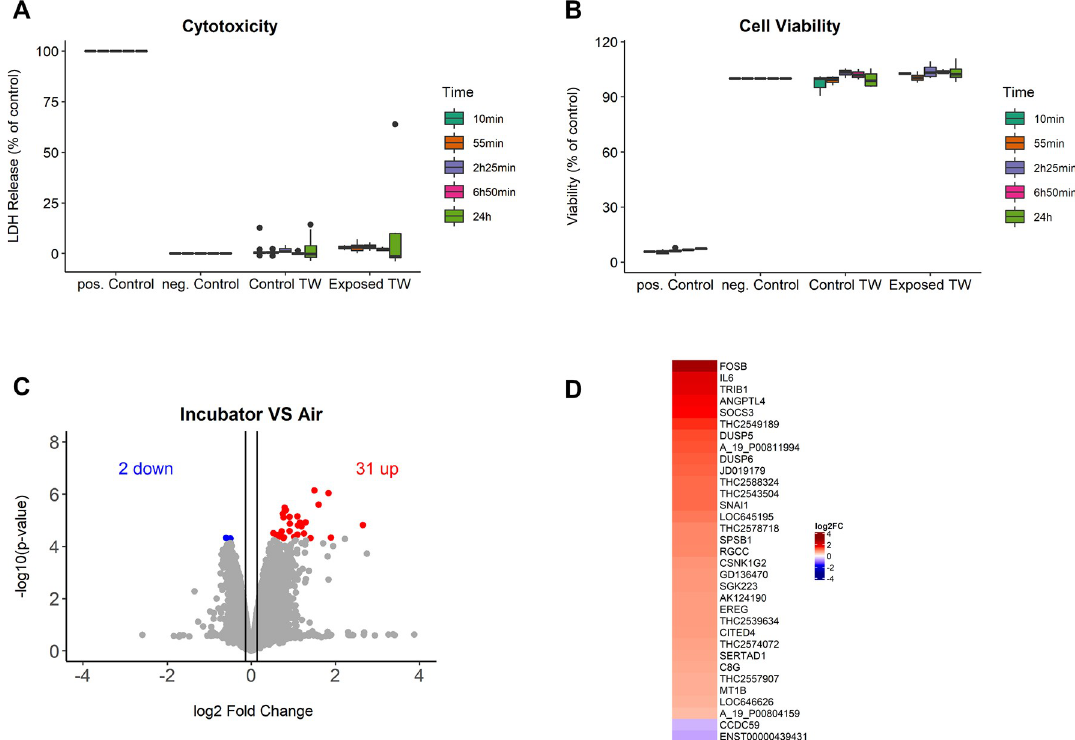
Fig 4. Effect of whole pollen and mock exposure in cellular health of BEAS-2B. (A) cytotoxicity (LDH), after dosing 10 mg pollen to BEAS-2B cells, and (B) cell viability of the cells (Alamar blue), for the different incubation times. (C) volcano plot and (D) heatmap of the effect of mock experiments (no pollen) on BEAS-2B, analysed by genome-wide gene expression arrays after 2h25 min. Incubator cells are used as control. Significant regulated genes were marked in color. N � 3 in all cases.